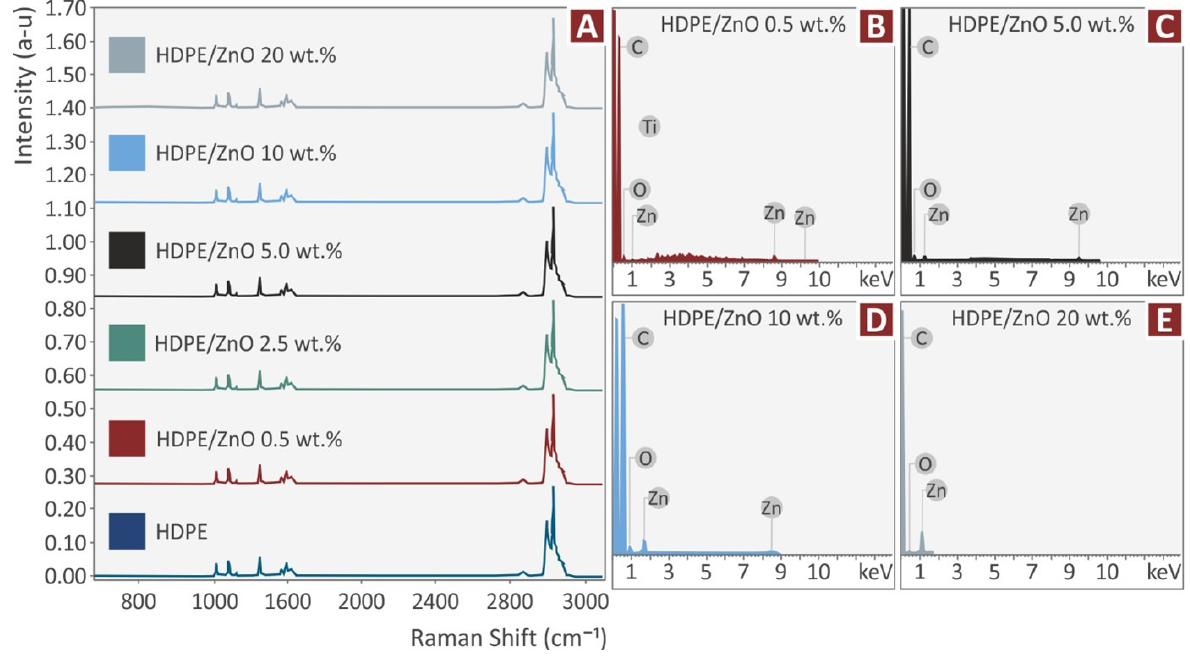
Figure 10. ( A ) Raman spectra for unfilled HDPE thermoplastic and HDPE with ZnO composites and EDS results for ZnO loadings in the composites of ( B ) 0.5 wt.%, ( C ) 5 wt.%, ( D ) 10 wt.%, and ( E ) 20 wt.%.